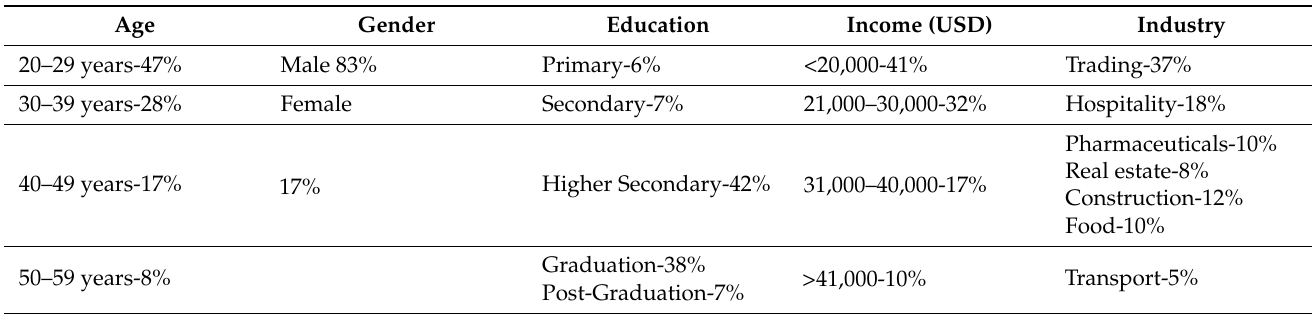
Table 2. Demographic profile of respondents.